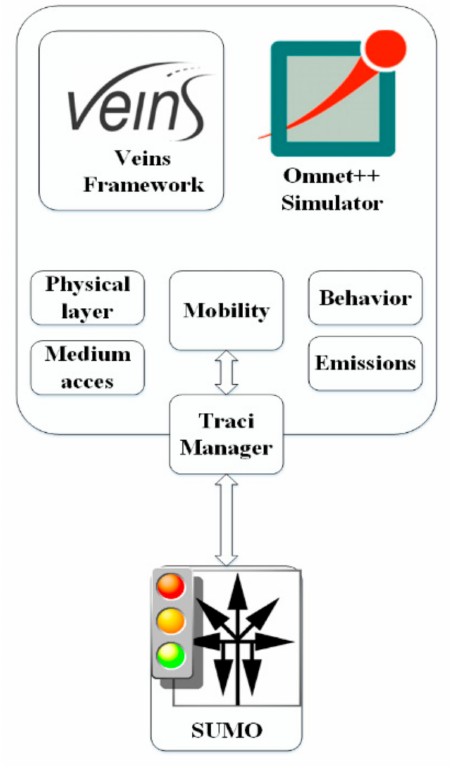
Figure 5. Simulation flow. Table 3. Wireless communication